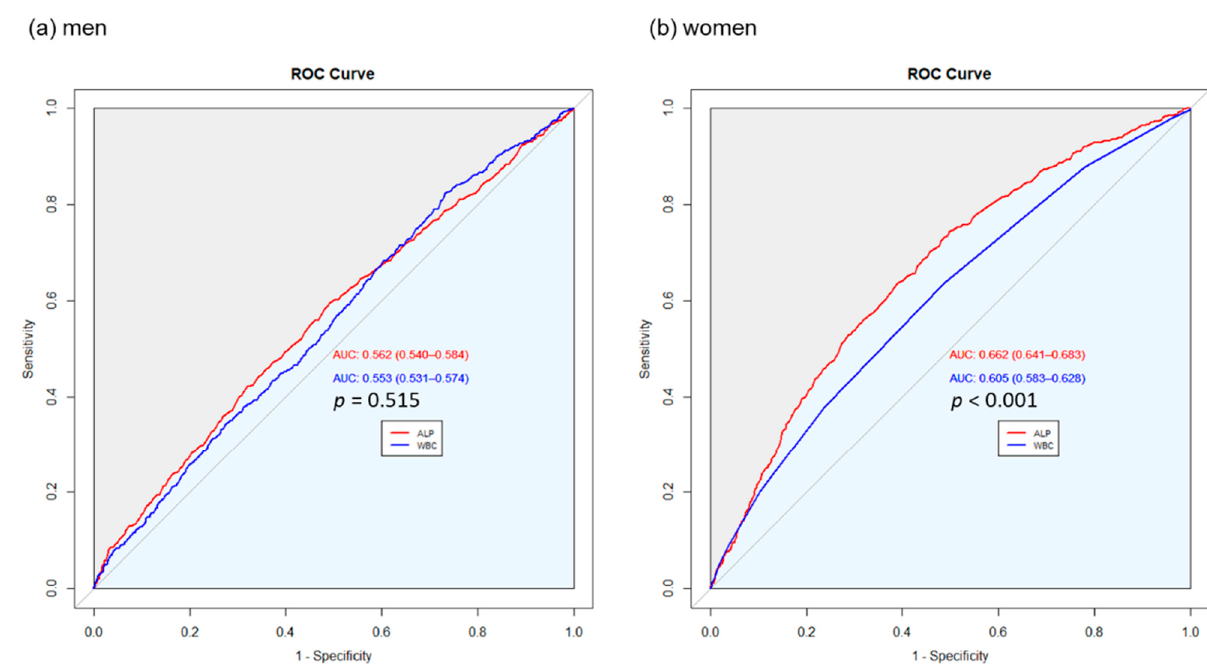
Figure 3. Comparison of the predictability of serum ALP levels and whole blood WBC counts for the presence of LSMI in ( a ) men and ( b ) women.